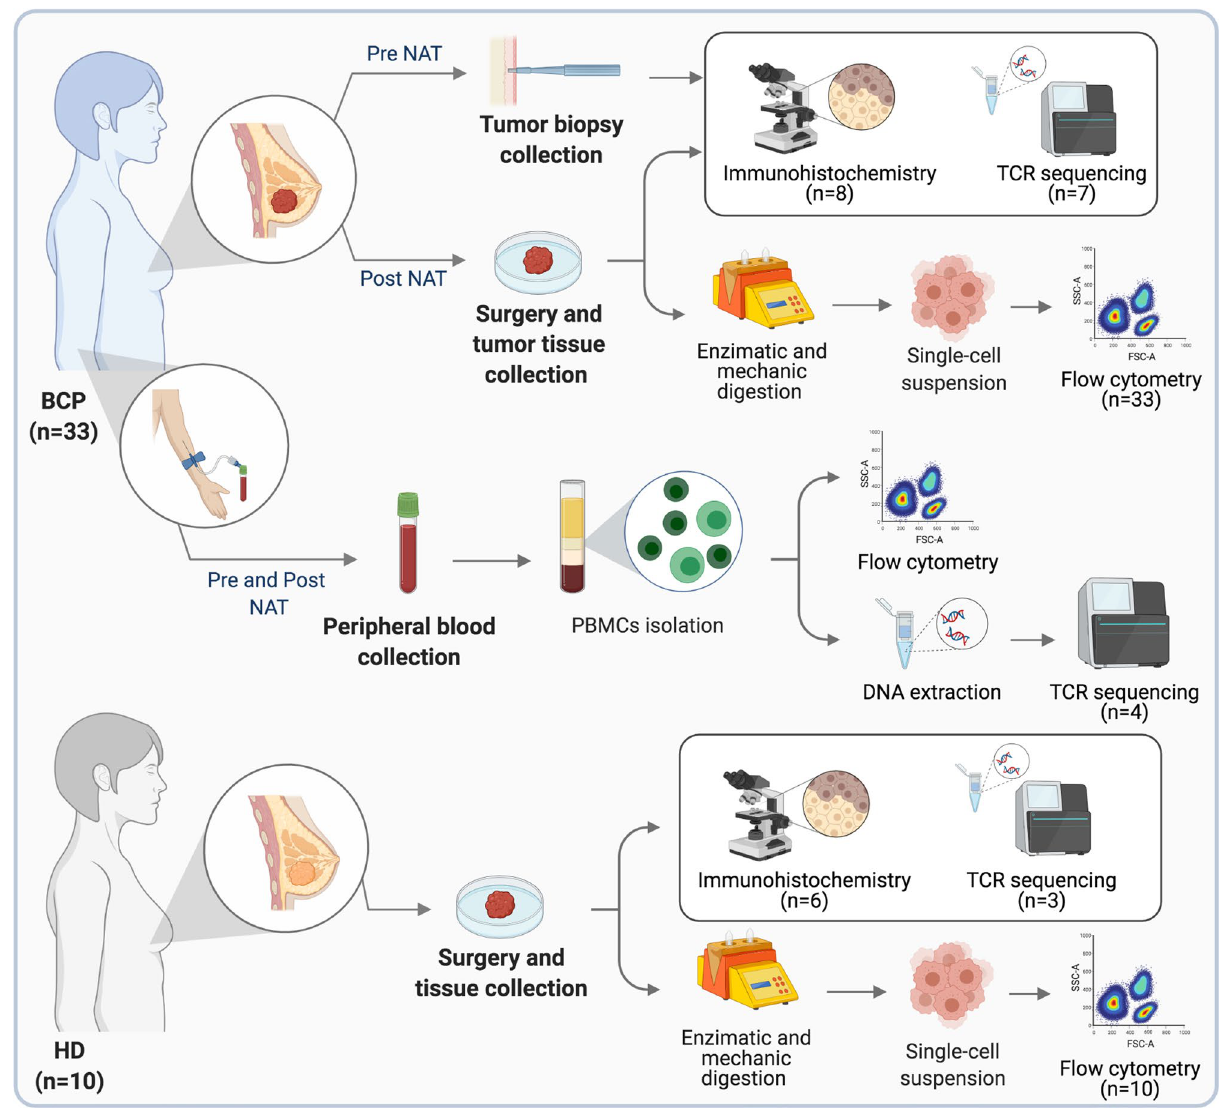
Figure 1. Experimental design. Breast cancer patients (BCP) and healthy donors (HD) were included in the study. From the patient group, biopsies and tumors were taken before and after NAT, respectively, and IHC and TCR sequencing were performed. Additionally, a section of the tumor sample was processed by enzymatic and mechanical digestion and used to evaluate different cell populations by flow cytometry. A blood sample was also taken from each patient before and after NAT to assess the activation status of T cells by flow cytometry and for TCR sequencing. From the HD group, breast tissue was taken during surgery for IHC, TCR sequencing and flow cytometry. This figure was created using BioRender (https:// biore nder.